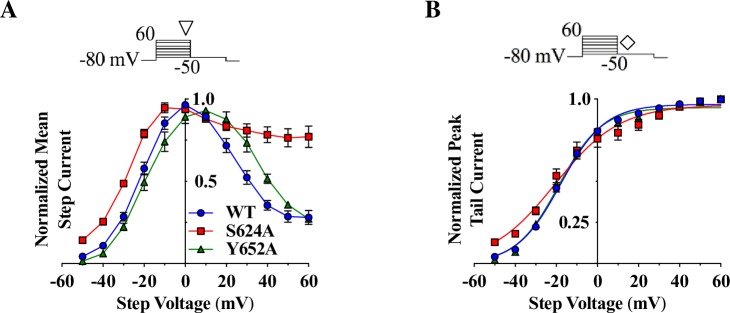
Comparison of unaffected step and tail currents from WT hERG, S624A, and Y652A hERG mutants.A) Step I-V curves for WT (○, blue), S624A (□, red), and Y652A (△, green) from a step depolarization protocol (top; currents measured at ▽). Rectification of S624A currents was reduced in comparison to WT current, with more than twice the amount of normalized current remaining for S624A (0.77 ± 0.06) compared to WT (0.28 ± 0.04) at +60 mV. B) WT, S624A, and Y652A tail I-V curves from a step depolarization protocol (top; currents measured at ◊). Boltzmann fits generated the following V0.5 of activation (neither of which were different from WT; p > 0.8 for WT-mutant comparisons): WT V0.5 = -16.5 ± 1.1 mV, S624A V0.5 = -17.7 ± 3.2 mV, and Y652A V0.5 = -16.5 ± 1.0 mV. The slopes for the activation curves were 11.7 ± 0.45 for WT, 16.3 ± 1.62 for S624A (p = 0.0033 compared to WT), and 12.5 ± 0.84 for Y652A (p = 0.7913 compared to WT); nWT = 14, nS624A = 9, nY652A = 9, one-way ANOVAs.